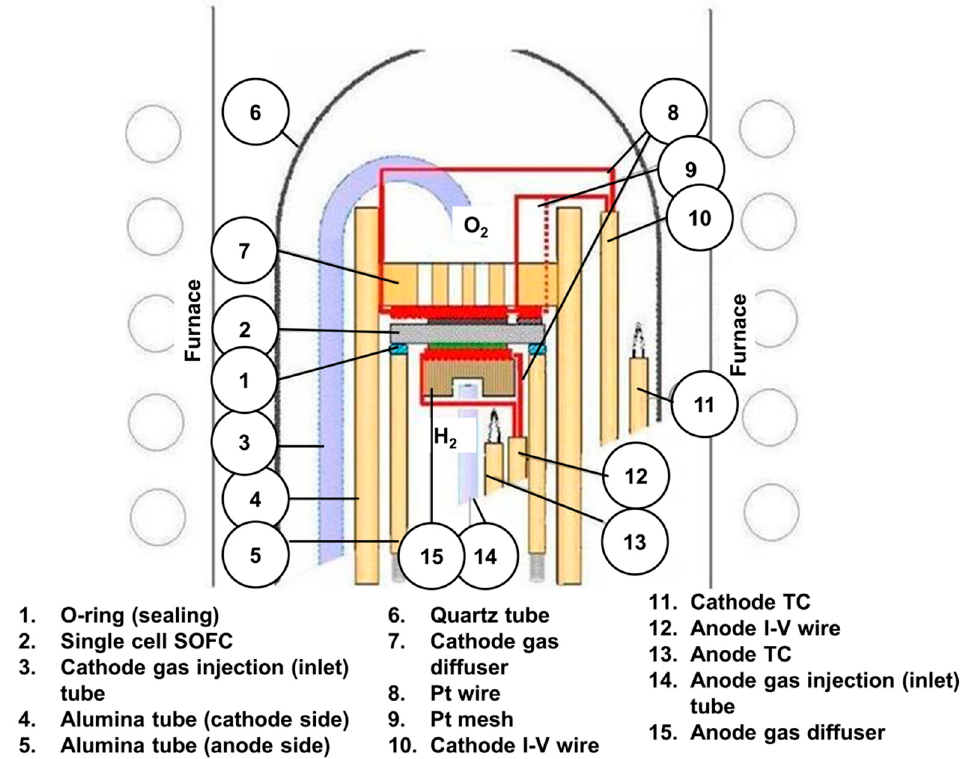
Figure 4. Schematic of the SOFC testing chamber.